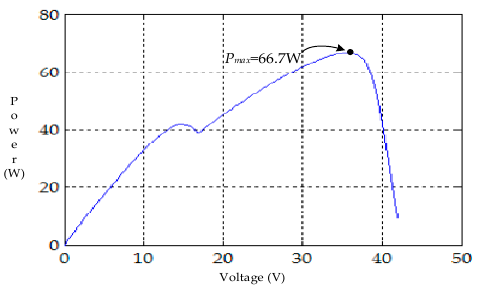
Figure 15. Simulation of P–V characteristic curve in Case 5.